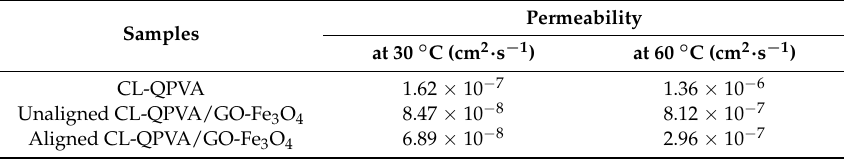
Table 1. Methanol permeability a of KOH-doped CL-QPVA and KOH-doped CL-QPVA/GO-Fe 3 O 4 nanocomposites b prepared with and without the magnetic field alignment membrane at 30 ◦ C and 60 ◦ C. KOH: Potassium hydroxide; CL-QPVA: Crosslinked quaternized polyvinyl alcohol; GO-Fe 3 O 4 : Graphene oxide-iron